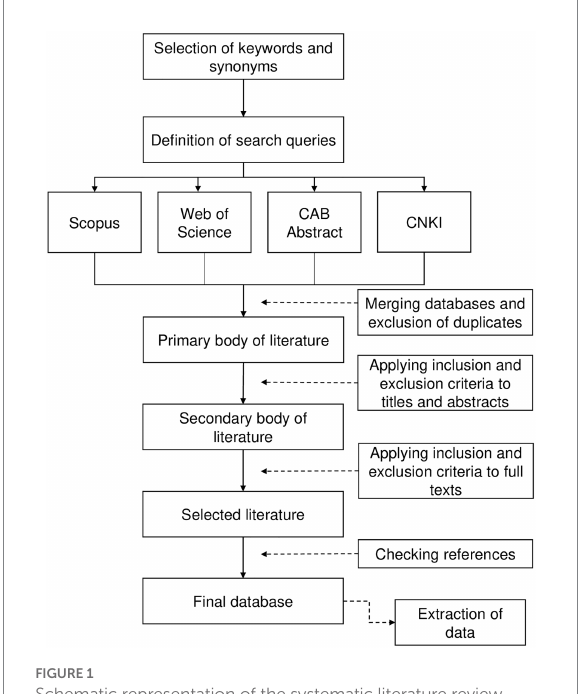
FIGURE 1 Schematic representation of the systematic literature review (based on Biesbroek et al.,